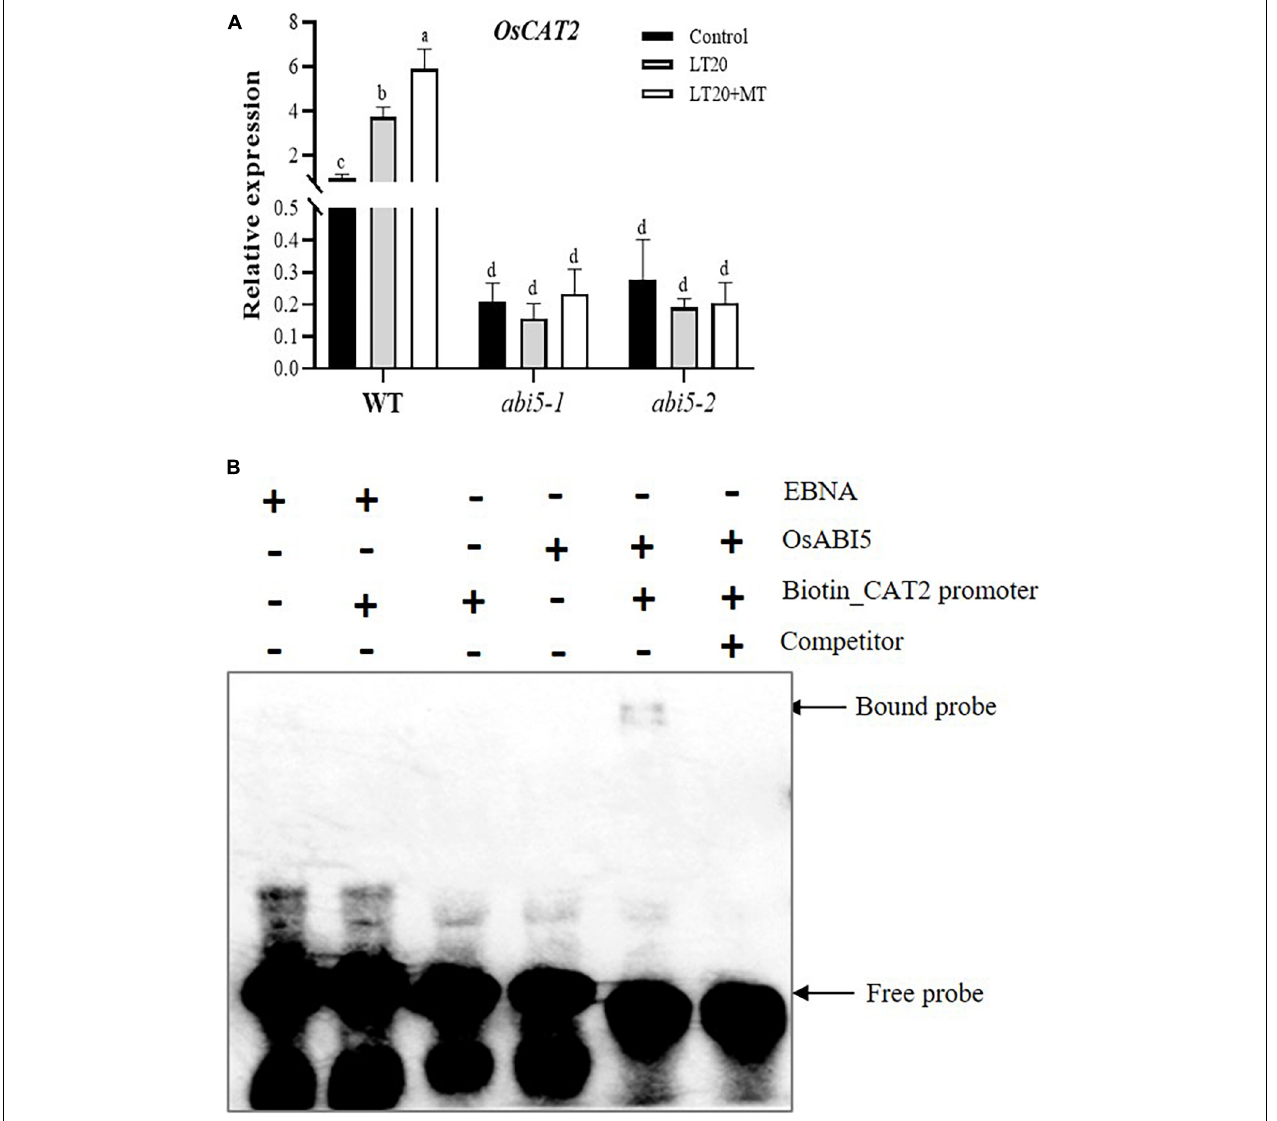
FIGURE 8 | Expression of CATALYSE 2 ( OsCAT2 ) under LT stress treated with exogenous MT and electrophoretic mobility shift assay (EMSA) assays for a direct interaction between OsABI5 and the OsCAT2 promoter. (A) Transcript abundance of OsCAT2 under LT stress (constant 20 ◦ C for 7 days) without (LT20) or with MT (LT20 + MT) treatment in WT and abi5-1 and abi5-2 mutants. (B) An EMSA validated the interaction of OsABI5 with the promoters of OsCAT2. The purified OsABI5 protein obtained using prokaryotic expression was used for the in vitro assay, and the EBNA protein was used as a negative control. Unlabeled probes (competitor) were subjected to cold competition experiments (100 × ). Different letters denote significant variations between the treatments, and the average values were measured by Tukey’s HSD test at p < 0.05. Data were represented as mean ± SE of six biological replicates. “+” and “–” indicate the presence or absence, respectively, of proteins and probes in the loading mixture. About 4% of the polyacrylamide gel was used here.